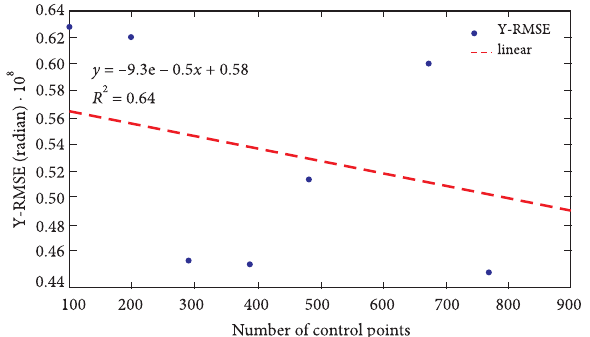
Fig. 8. RMSE (Latitude) changing rate by increasing control points